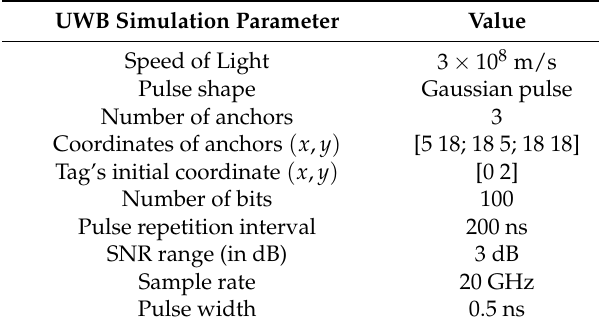
Table 1. UWB simulation parameter values.